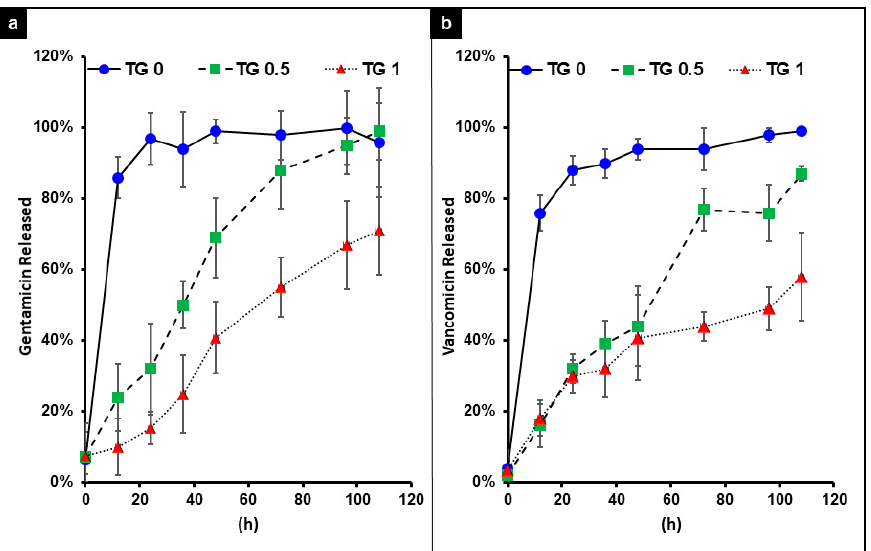
Figure 5. The release time of gentamicin ( a ) and vancomycin ( b ) encapsulated by hydrogel with 3 different concentrations of transglutaminase (TGase) added for crosslinking. With no TG the release of both drugs was near instantaneous. As the concentration of TG increases, a better slow release of the drug was achieved.